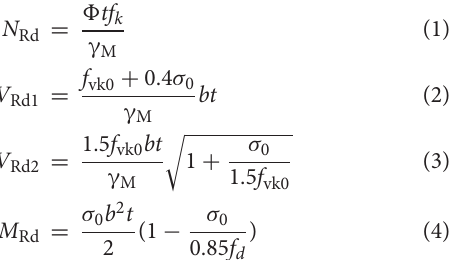
accelerograms corresponding to the employed seismic motions are presented in Figure 10